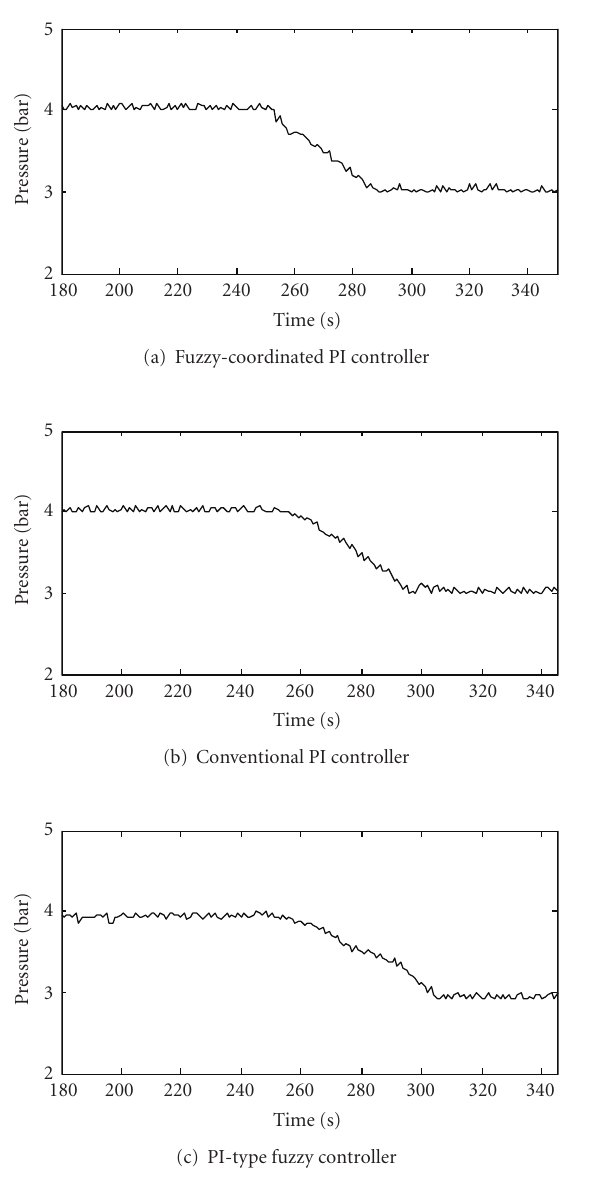
Figure 13: Experimental results, output responses of di ff erent controllers for set point change from 4 bar to 3bar.